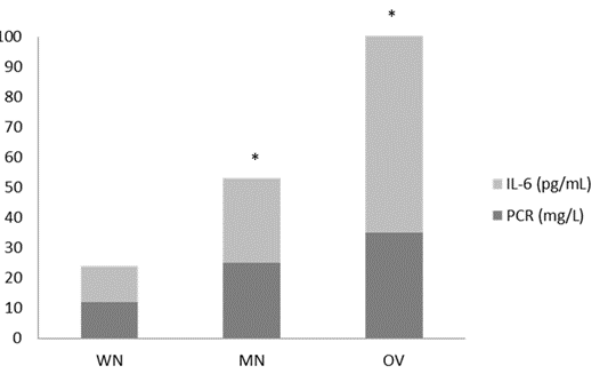
Figure 2. CRP and IL-6 values according to nutritional status (WN: well-nourished; MN: